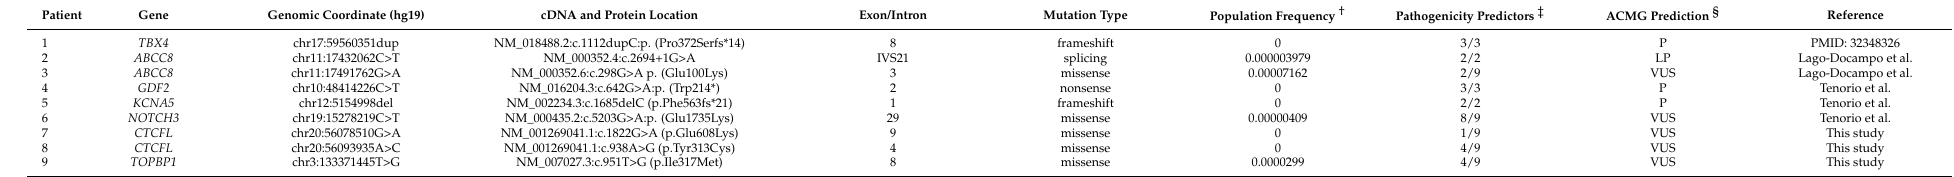
Table 3. Variant